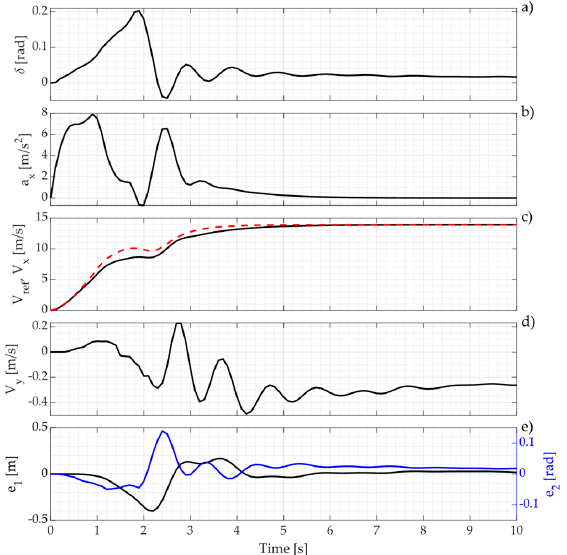
Figure 12. Results obtained during the left turn maneuver in MIL configuration (see Figure 9). Measured vehicle states: ( a ) Front wheels steering angle δ ; ( b ) Longitudinal acceleration a x ; ( c ) Longi- tudinal speed reference V ref (red, dashed) vs. Actual longitudinal speed V x (black, solid); ( d ) Lateral speed V y ; ( e ) Cross track e 1 (black, solid) and Relative yaw angle e 2 (blue,